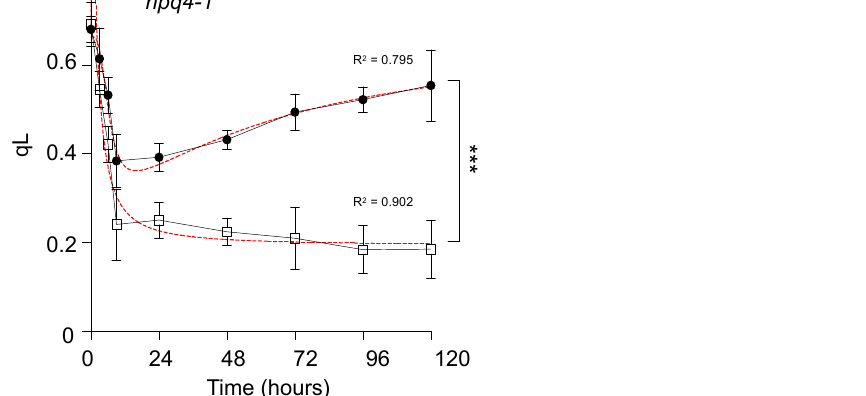
Figure 5. Changes in the fraction of open PSII centers, qL, in wild-type and npq4-1 mutants during high light illumination. Leaves of 4-weeks-old seedlings grown in a growth chamber were treated with high light (HL) at 700 µ mol photons m − 2 s − 1 and dark-adapted for 10 min before the measurement of qL. The parameter qL was calculated as described in Section 4. Each point represents the mean of at least four experiments (SD indicated by the bar). Regression line plotted as red dashed line estimated via nonlinear least square regression. R 2 denotes the regression coefficient. Significance differences of fitted curves are indicated by asterisks (*** p < 0.001) compared to the WT as determined by unpaired Student’s t test.